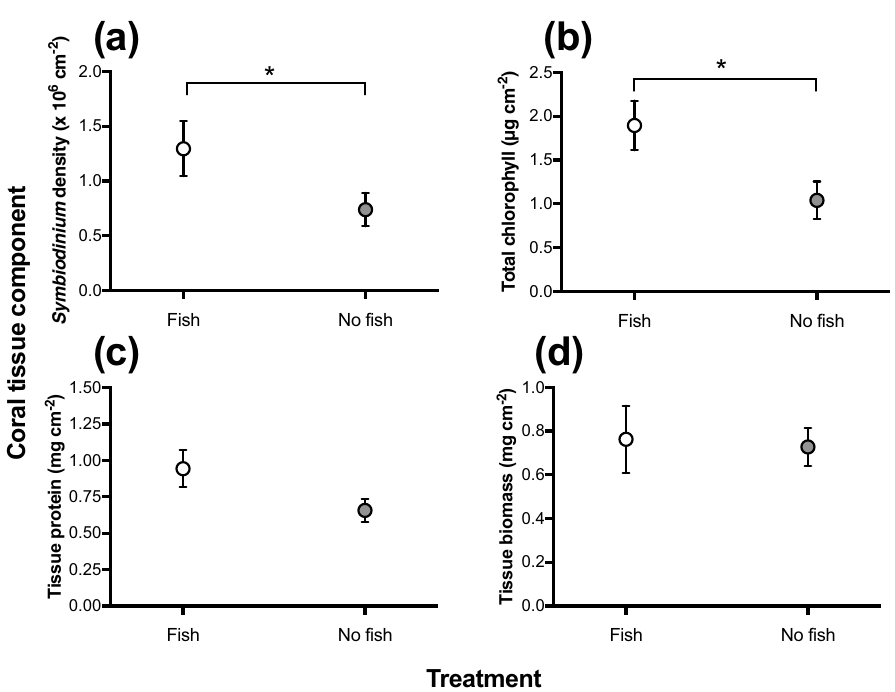
Fig 1. In situ levels of (a) endosymbionts ( Symbiodinium density x10 6 cm -2 ), (b) total chlorophyll (chl a + chl c , μ gcm - 2 ), (c) tissue protein (mg cm -2 ), and (d) tissue biomass (calculated via ash-free dry weight, mg cm -2 ) of naturally occurring P . damicornis colonies, with D . aruanus (n = 5) and without fish (n = 5) present. ( � ) denotes a significant difference between fish treatments, and error bars show S.E.